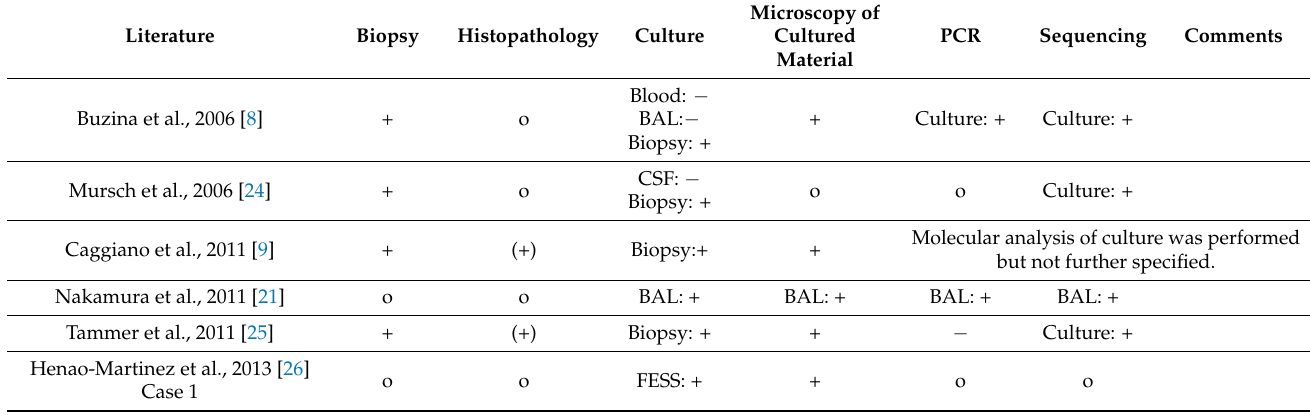
Table 1. Overview of several case reports describing the diagnosis of Scedosporium apiospermum involved in brain abscesses. + positive, (+) indicative of fungal infection, − negative, o not performed or not reported, CSF cerebrospinal fluid, BAL bronchoalveolar lavage, FESS functional endoscopic sinus